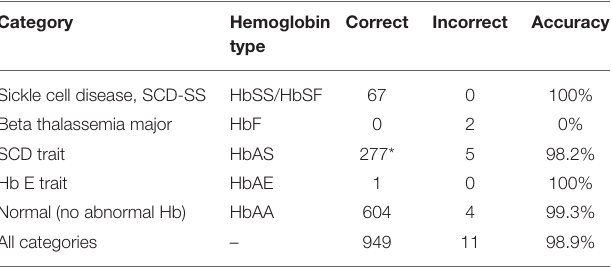
TABLE 2 | Diagnostic accuracy of Gazelle compared to hemoglobin electrophoresis.